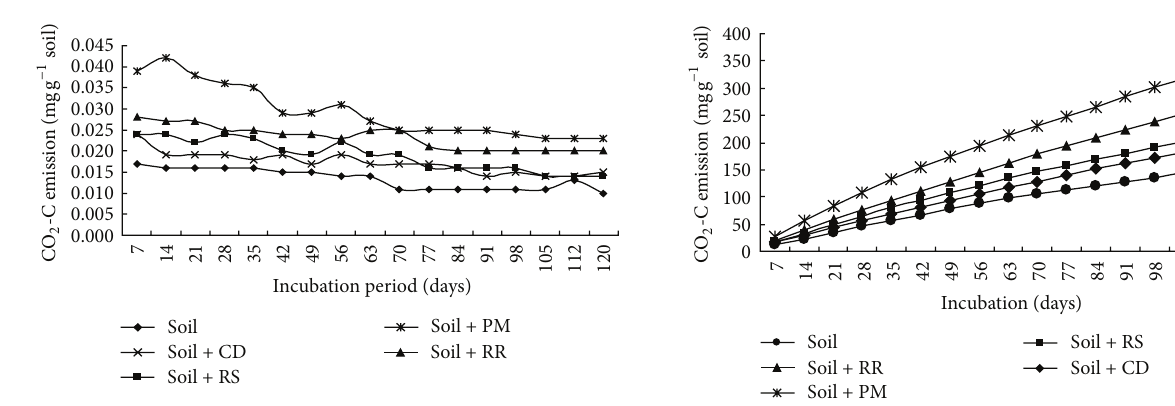
Figure 5: Cumulative CO 2 -C evolution from different organic